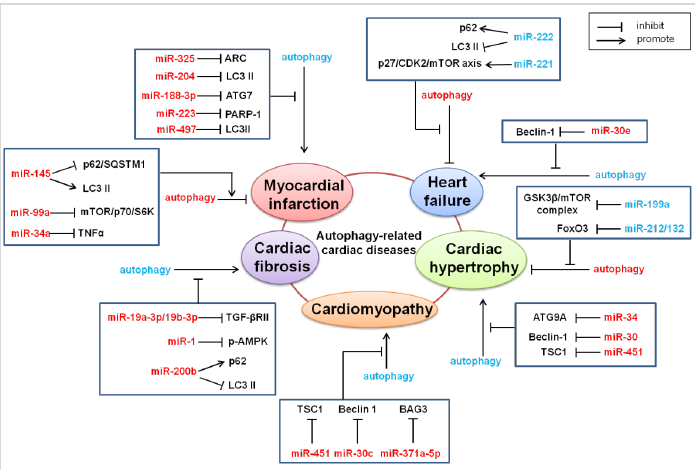
Figure 2. Summary of miRNAs regulating cardiac autophagy and related heart diseases. The molecular mechanisms of the miRNAs regulating the autophagy and autophagy-related heart diseases are shown in the figure. See text for detailed explanations. Arrows represent the promotion effect. T bars represent the inhibition effect. Red represents the negative regulation in diseases. Blue represents the positive regulation in diseases.